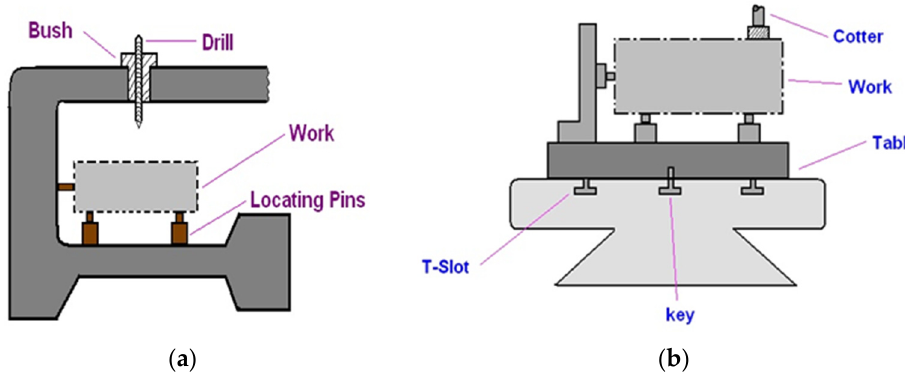
Figure 1. Typical example of ( a ) a drilling jig, ( b ) a machining fixture [21].